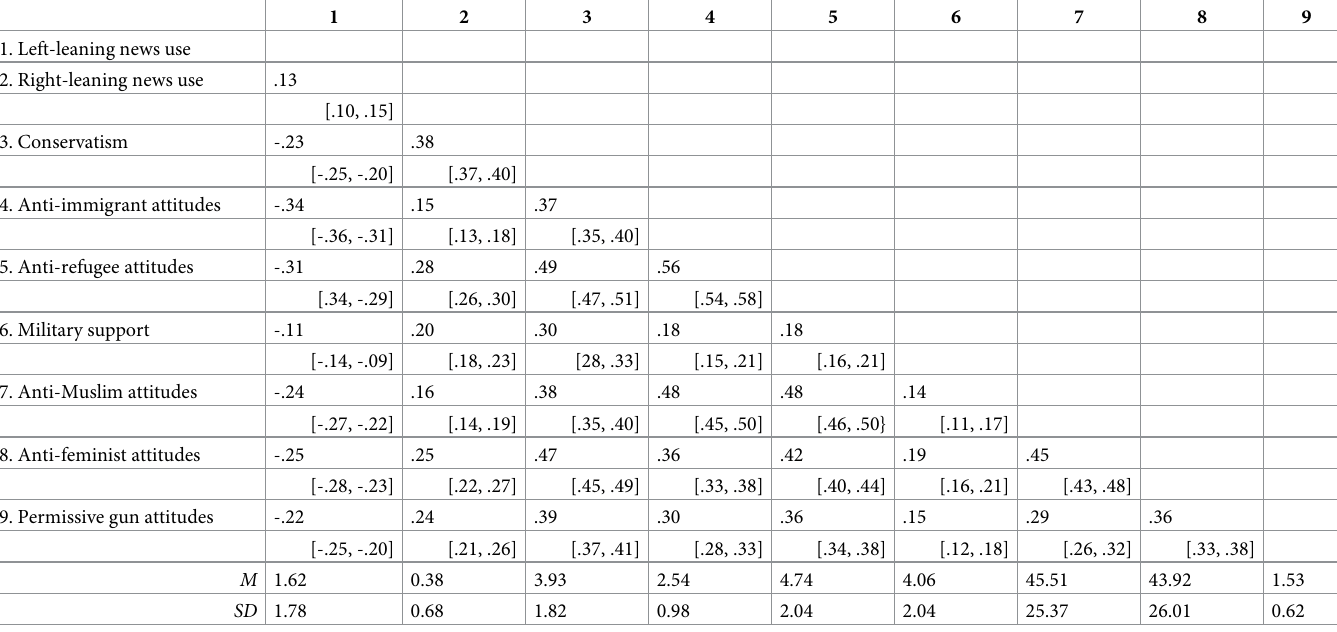
Table 1. Correlations between variables (nationally representative cross-sectional